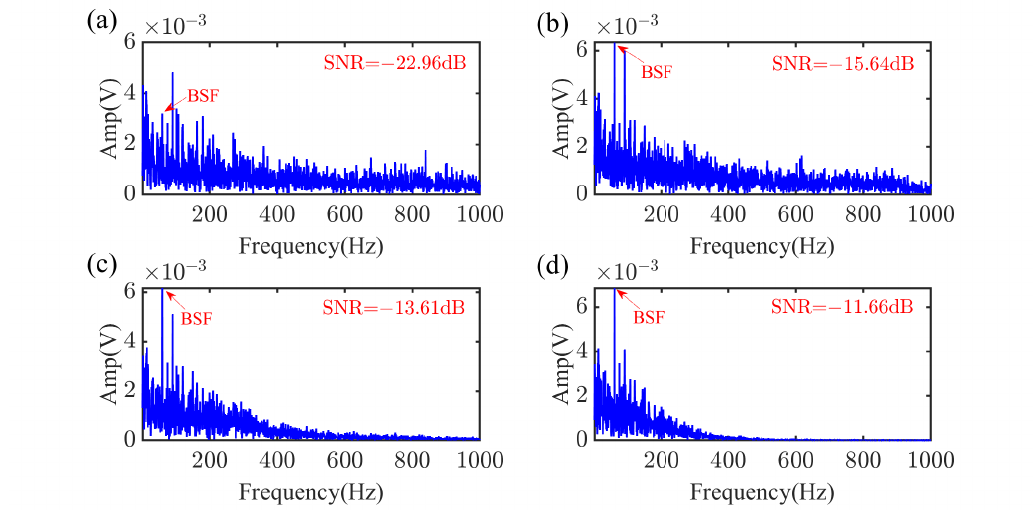
Figure 10. Envelope spectrum analysis results: ( a ) original signal; ( b ) band-pass filter; ( c ) VMD; ( d ) the proposed method.